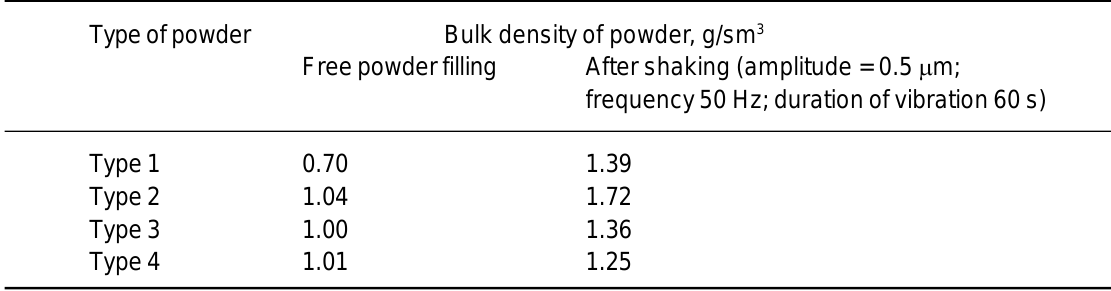
Table 4. Rheological properties determined by dynamic